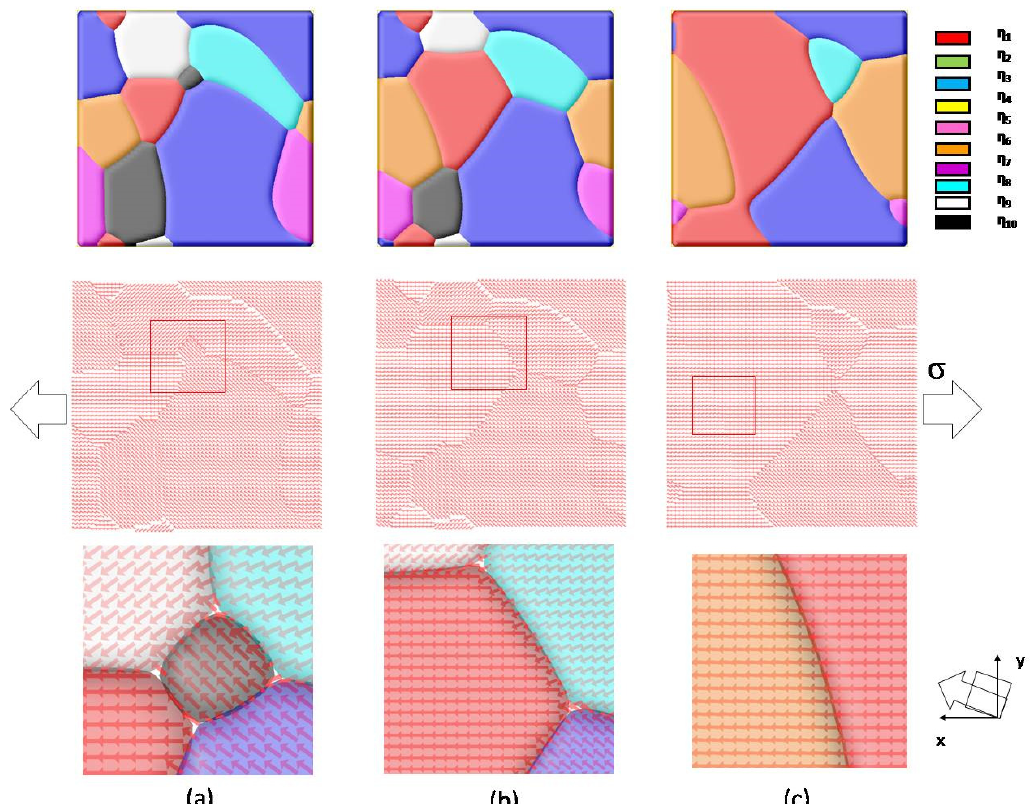
Figure 4. ( a – c ) The grain growth process at a tensile stress of 10 MPa along the x -direction. The vectors indicate the orientation of grains, which is assumed to be − 45°~45°with a random distribution. In this work, the orientation of grains η 1 ~ η 10 are 0°, − 7.6°, 35.9°, 9.7°, − 17.1°, 2.88°, 23.1°, − 23.7°, − 35.8°, and 43.7°, respectively.